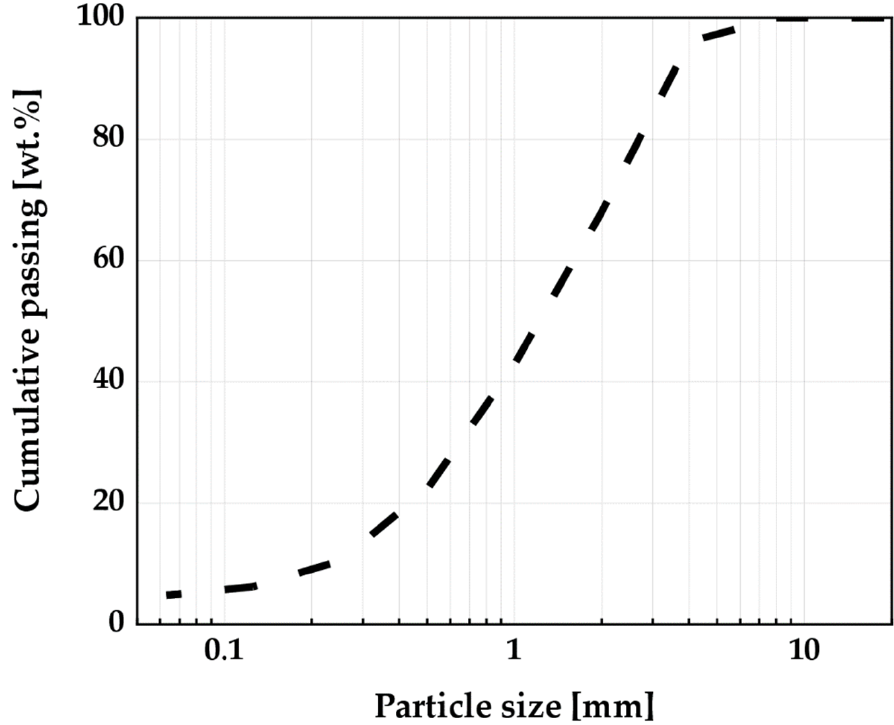
Figure 1. Particle size distribution of fine aggregate determined according to DIN EN 933-1 [44].